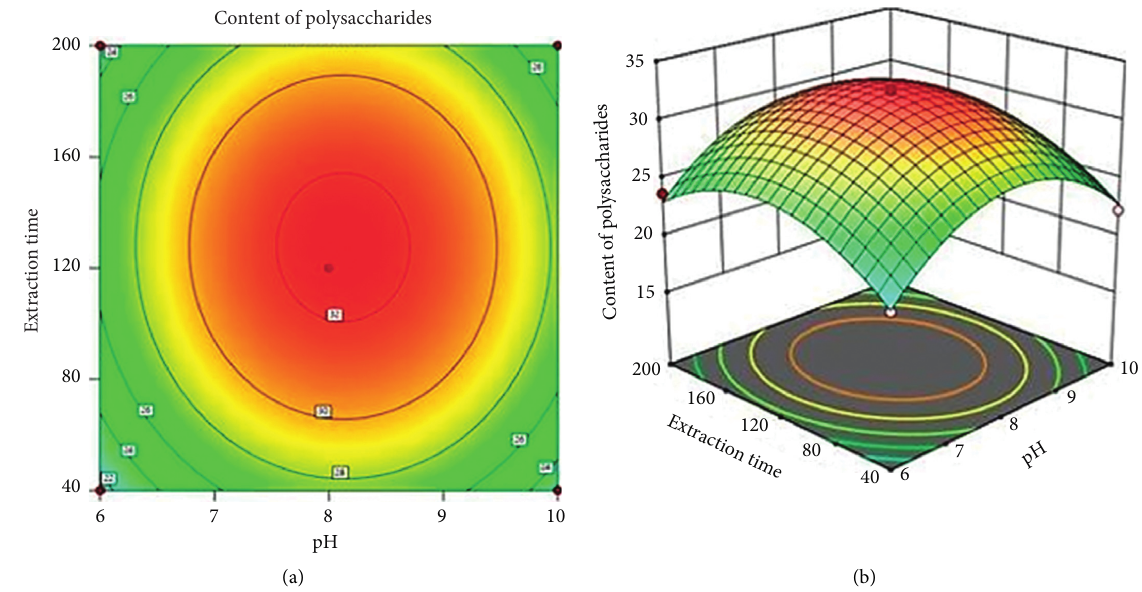
Figure 3: Simultaneous effect of pH and extraction time on the content of